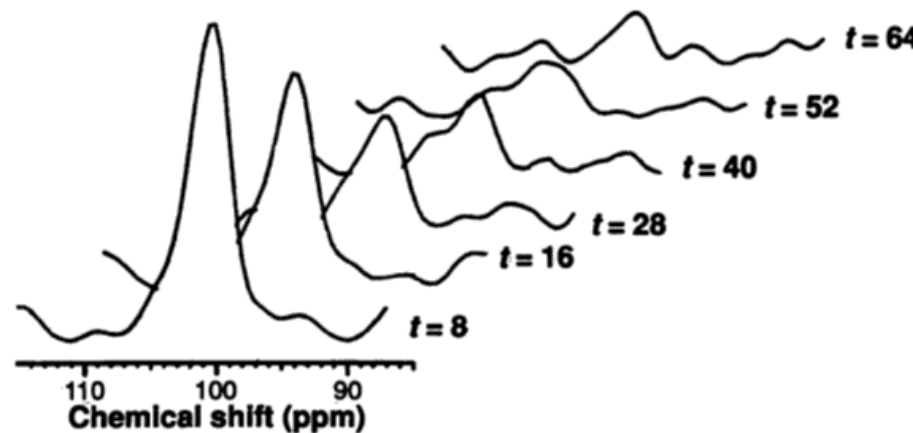
Figure 2. Longitudinal 13 C MR measurements of hepatic glycogen at natural abundance in a healthy human subject during 64 h of fasting (at the indicated time points). 1 H decoupling was applied during acquisition to remove the J-coupling-induced splitting of the [1- 13 C]glycogen resonance at 101 ppm. This figure was adapted from reference [7], with permission.